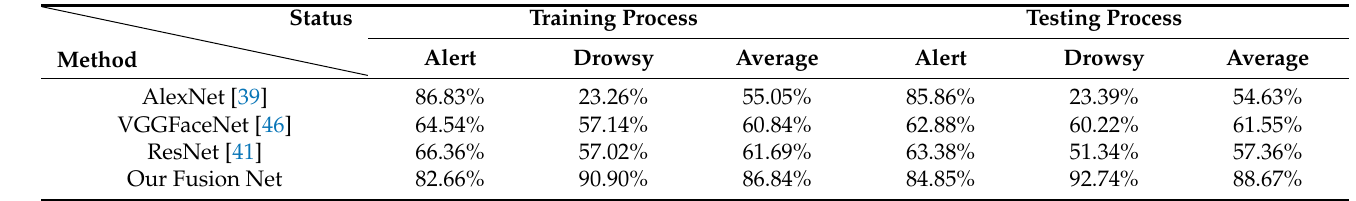
Table 4. The accuracy comparison of our methods and the benchmark models with the operation point of 0.5.